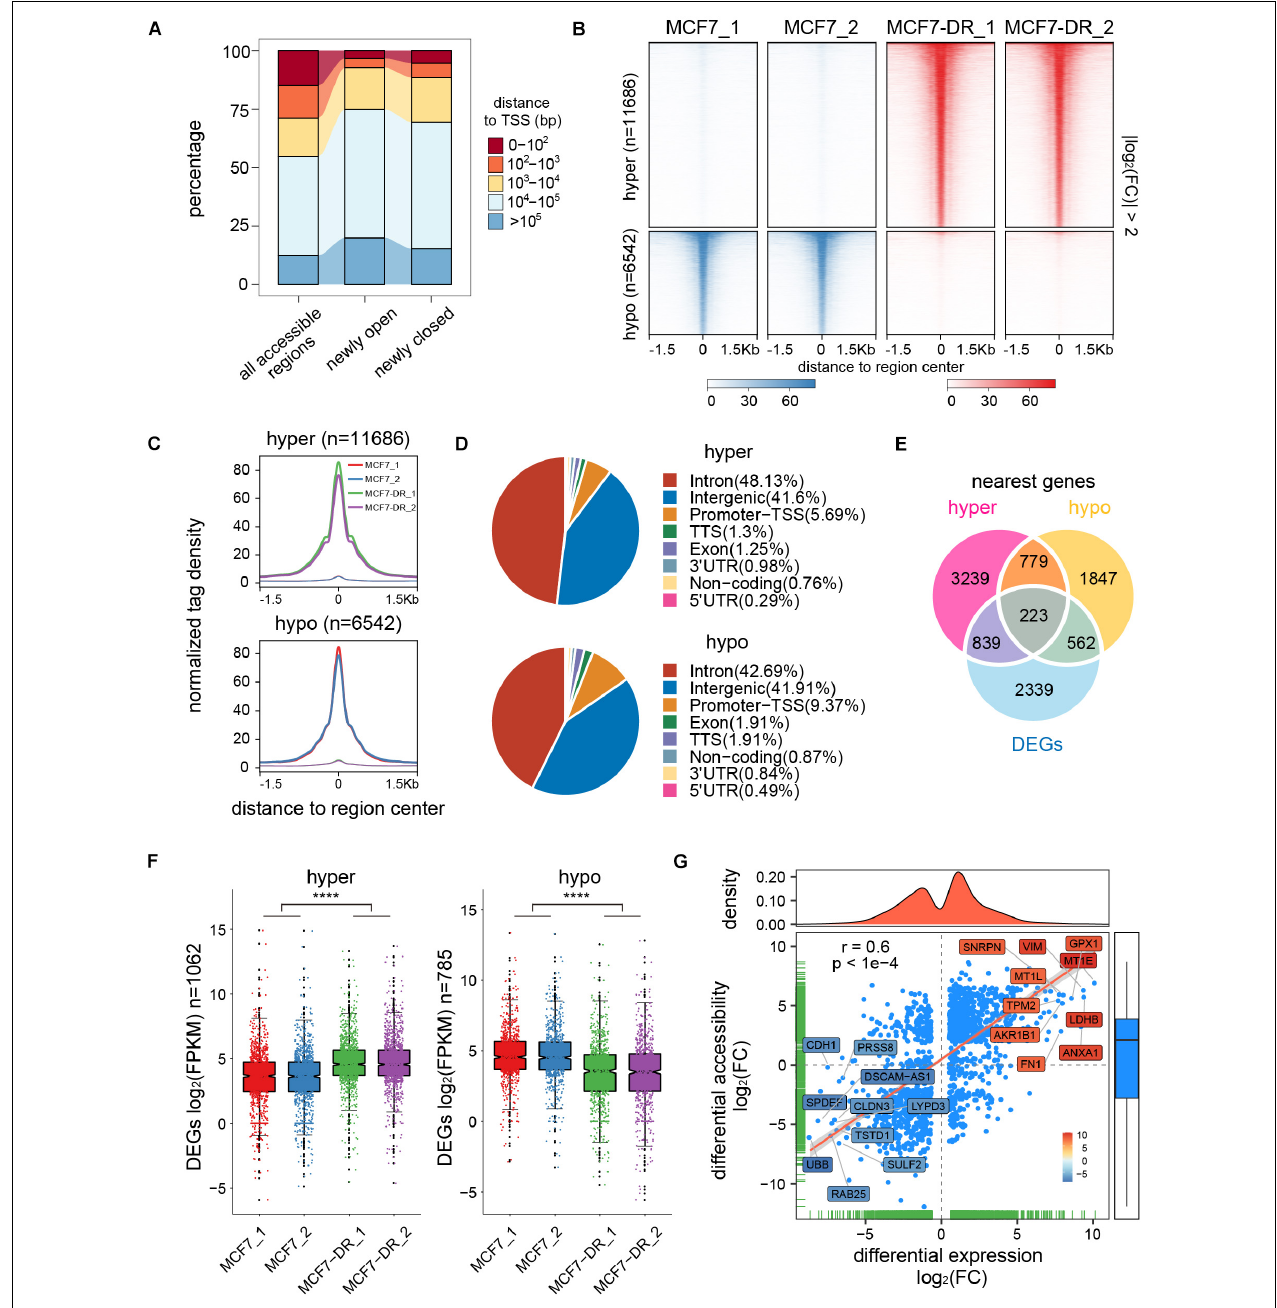
FIGURE 3 | Identification and analysis of differentially accessible regions (DARs). (A) Distance to the closest transcription start site (TSS) of all accessible regions and newly open and closed regions. (B) Heatmap representation of normalized ATAC-seq signal in parental and doxorubicin-resistant MCF7 cells over DARs. The top panel shows read signal over the 11,686 hyper-accessible regions in MCF7-DR cells, while the bottom panel shows read signal over the 6,542 hypo-accessible regions. Signals within 1.5 Kb surrounding the center of DARs are displayed in descending order. (C) Profiles of normalized tag density across a genomic window of ± 1.5 Kb surrounding the center of hyper- (top) and hypo-accessible (bottom) regions. (D) Pie chart showing the proportion of hyper- (top) and hypo-accessible (bottom) sites within the indicated genomic regions: introns, exon, intergenic regions, 3 (cid:48) UTR, 5 (cid:48) UTR, promoters-TSS, TES and no-coding regions. Peak summits located up to 1 Kb upstream and 100 bp downstream of the TSS are determined as promoter-TSS region. (E) Venn diagram illustrating the overlap among DEGs and the nearest genes of differentially accessible regions. (F) Box plots for mRNA expression levels of DEGs relative to hyper- (left) and hypo-accessible (right) regions. Notches of the boxes indicate medians. The P values were calculated by Wilcoxon’s signed-rank test. **** P < 0.0001. (G) Correlation analysis between DARs and their nearest DEGs. Each blue-colored dot represents a gene that is significantly differentially expressed and associated with chromatin accessibility changes. The top- and bottom-ranked 10 DEGs are labeled and shown in different colors based on the log 2 (FC) of the average FPKM. The Pearson’s correlation coefficient (r) and the corresponding P value are shown.